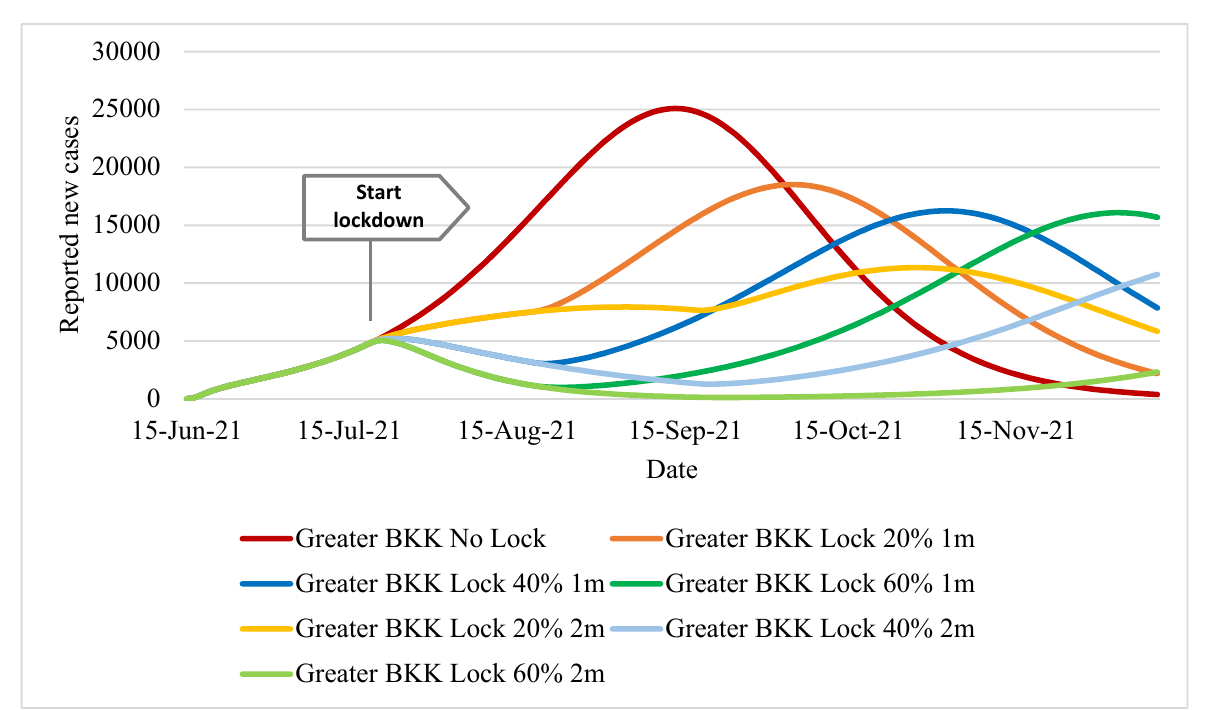
Figure 3. Daily new reported cases in Greater Bangkok.